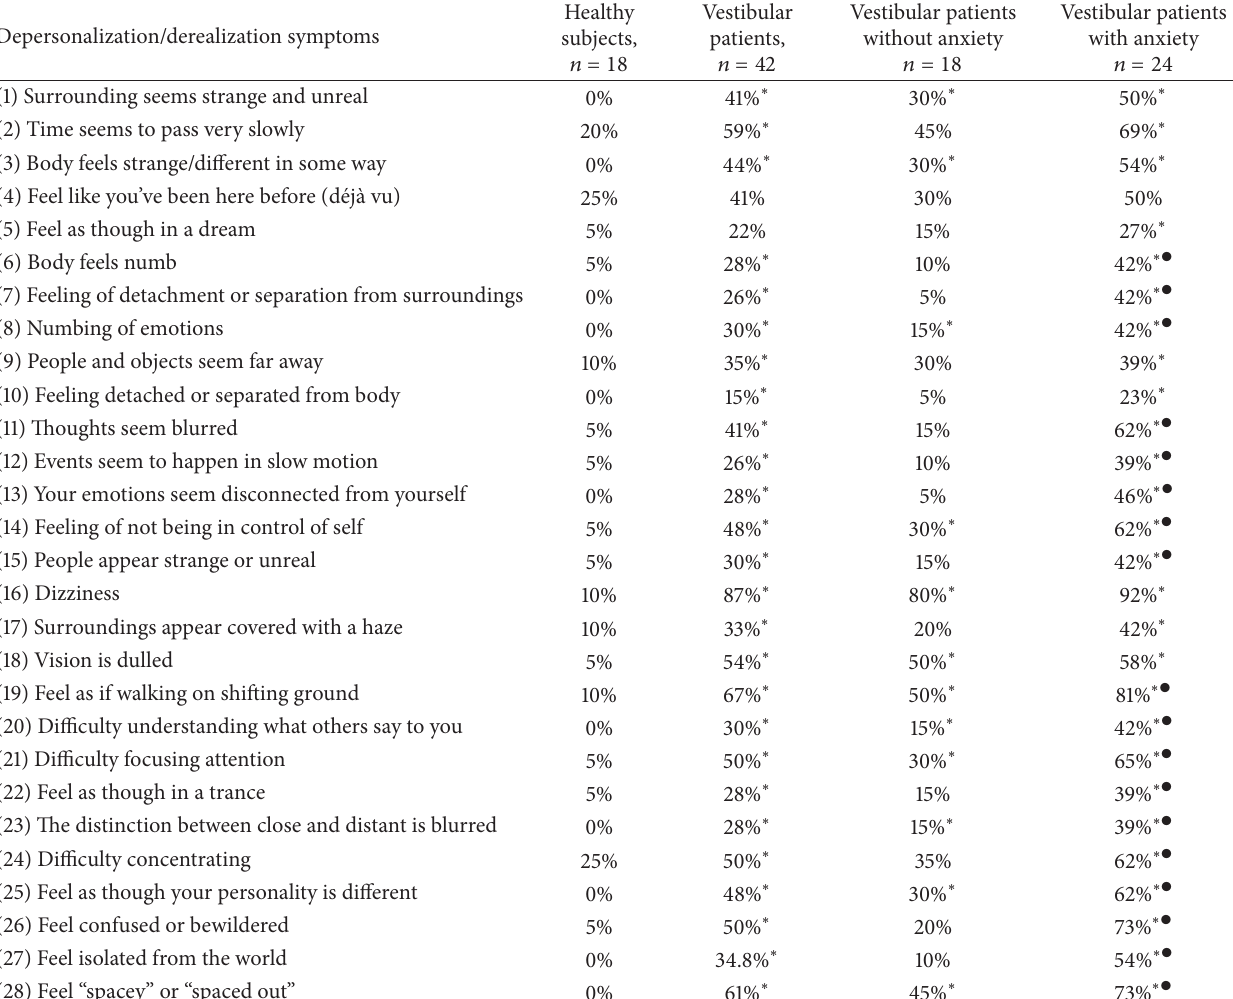
Table 3: Frequency for each symptom included in the Cox and Swinson Dp/Dr inventory in the three groups participating in the study. Depersonalization/derealization symptoms